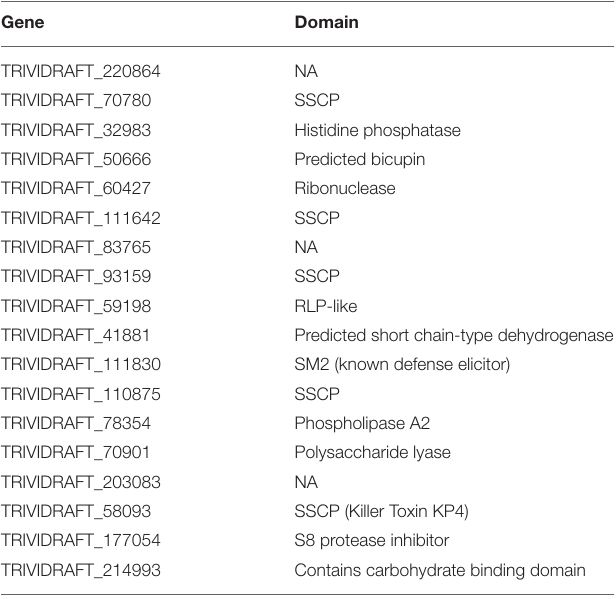
( Table 5 ). The 1 sir1 mutants also had several hydrolases and methyltransferases upregulated at this time point ( Table 5